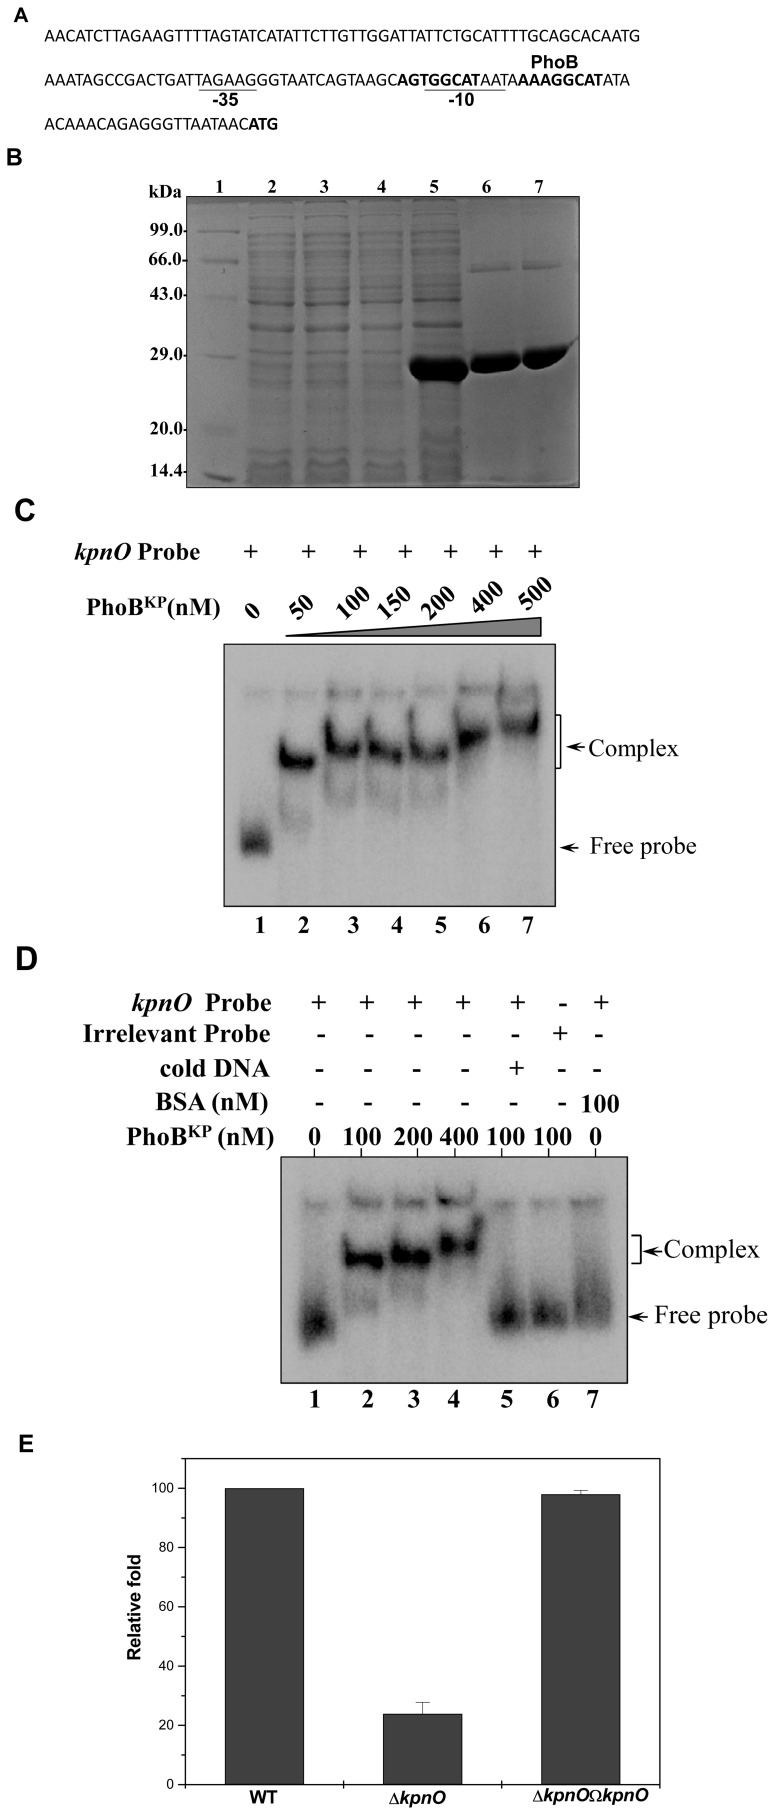
PhoB regulates kpnO in K. pneumoniae.A. Promoter region analysis of kpnO. The numbers in brackets represent the distance from the transcription start site. The −35 and −10 region in the promoter is underlined. Putative PhoB binding site has been shown in bold. B. SDS-PAGE profile of pET-phoB
KP. Lane 1: medium size marker, Lane 2: pET28C/BL21DE3 uninduced, Lane 3: pET28C/BL21DE3 induced, Lane 4: pET-phoB
KP/BL21DE3 uninduced, Lane 5: pET- phoB
KP/BL21DE3 induced, purified PhoBKP-fractions E1 and E2 (lanes 6–7) respectively. Protein samples after induction were subjected to SDS/PAGE (15% gel) followed by coomassie brilliant blue staining. C. Gel shift assays demonstrating the binding of PhoB to promoter of outer membrane protein kpnO in K. pneumoniae in a concentration dependent manner. Lane 1 (shows free probe), lanes 2–7 with increasing concentrations of PhoB protein (50 nM to 500 nM) respectively. Slower moving bound complexes and free probe has been indicated by arrows respectively. The gels are representative of at least three independent experiments. D. Gel shift assays demonstrating the sequence-specific binding of PhoB to kpnO using different controls as in lane 1 (shows free probe), lanes 2–4 (labeled kpnO promoter with increasing amount (100 nM, 200 nM and 400 nM) of PhoB), lane 5 (labeled kpnO promoter and PhoB with specific competitive inhibitor: 10 fold excess of unlabeled kpnO promoter), lane 6 (labeled non-specific DNA: promoter of gyrA and PhoB, 100 nM), lane 7 (labeled kpnO promoter with non-specific protein: BSA, 100 nM) respectively. The gels are representative of at least three independent experiments. E. Relative transcriptional level of kpnO in ΔphoB
KP and ΔphoB
KPΩphoB
KP strains determined using real time RT-PCR is showed in comparison with wild type. The wild type expression level is represented as one fold. Each bar represents the average value of three independent experiments. Error bars are standard deviations.